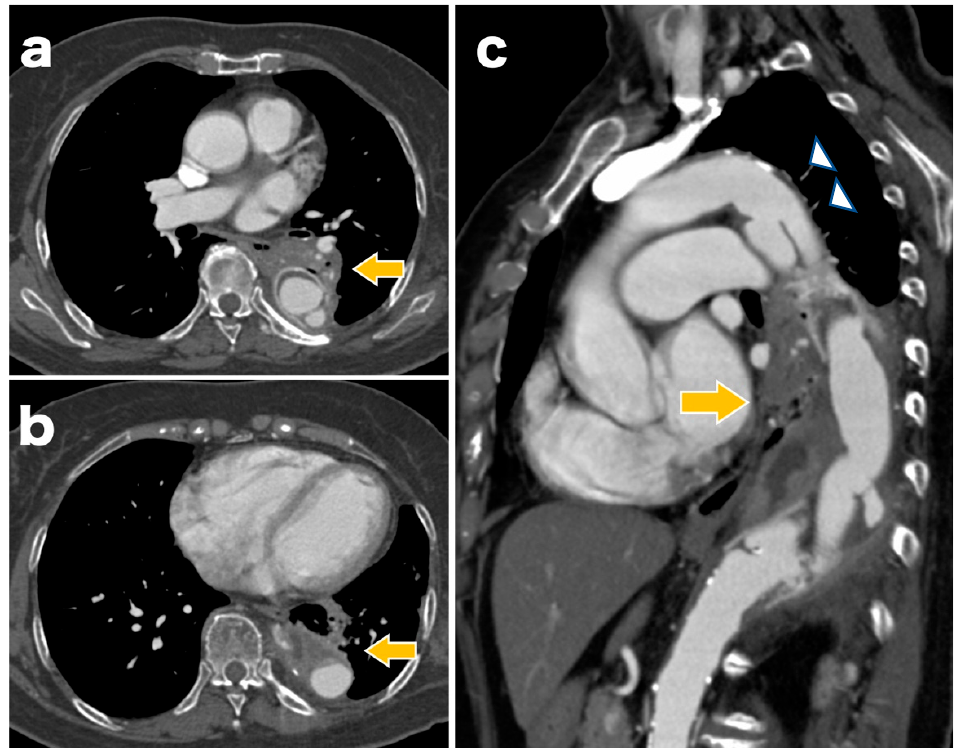
Figure 1. Contrast-enhanced computed tomography scan on admission showing infiltrative shadows and gaseous images in the lung fields around the graft (arrow). Although we could not directly signify the fistula between the aorta and the bronchus, the clinical history and CT findings led to the diagnosis of aortobronchial fistula (( a , b ): axial images; ( c ): sagittal image). Chronic aortic dissection findings are also observed on the proximal side of the graft replacement (arrowhead). CT, computed tomography.